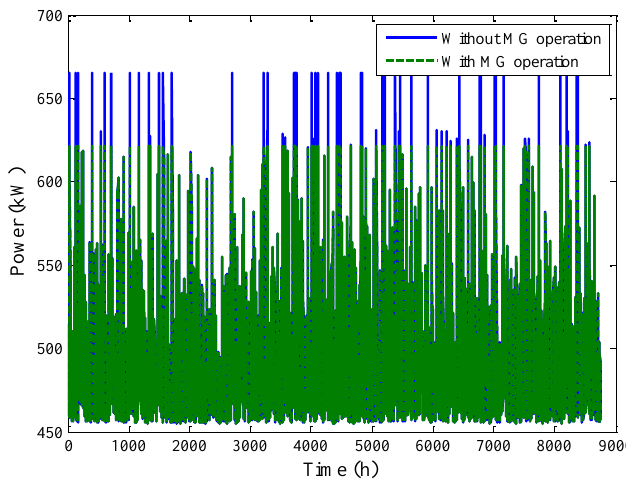
Figure 12. Power demand time series (Case study 1).